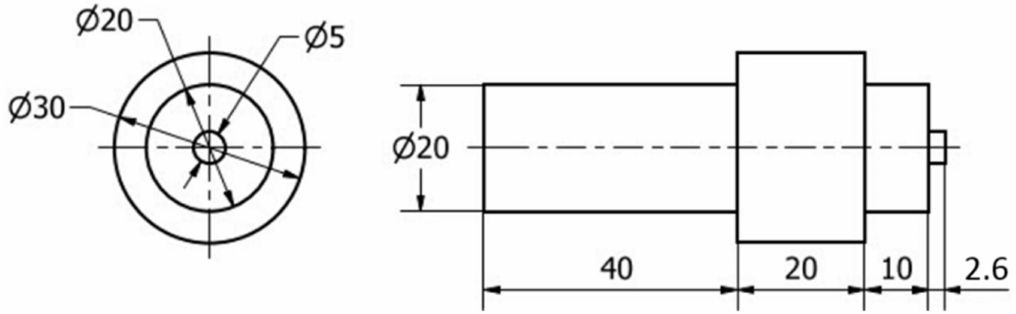
Figure 1. Dimensions of the FSSW tool (all dimensions are in